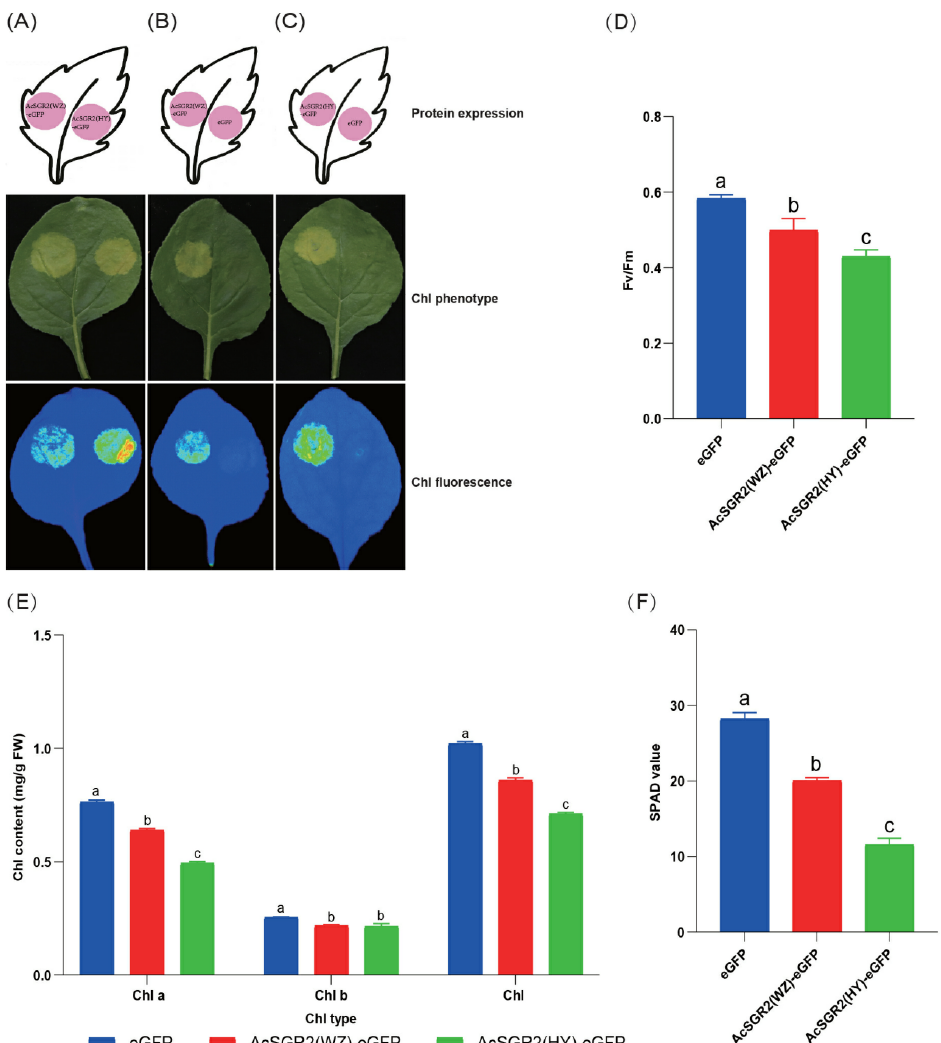
Figure 8. Transient overexpression of AcSGR2 in tobacco leaves. Detection of Chl degradation in 6 ‐ weeks ‐ old soil ‐ grown tobacco leaves ( A ) overexpressing 35S::AcSGR2(WZ) ‐ eGFP and 35S::AcSGR2(HY) ‐ eGFP, ( B ) overexpressing 35S::AcSGR2(WZ) ‐ eGFP and 35S:: eGFP, and ( C ) overexpressing 35S::AcSGR2(HY) ‐ eGFP and 35S:: eGFP. ( D ) Fv/Fm ratio. ( E ) Chl content, and ( F ) SPAD value. WZ, ‘Wuzhi no.3’; HY, ‘Hongyang’; eGFP, enhanced green fluorescence protein; AcSGR2(WZ), AcSGR2 from WZ; AcSGR2(HY), AcSGR2 from HY. The results were presented as the means ± SD of three replicates. The mean differences were identified with different letters based on the results of Tukey’s multiple range test ( p <